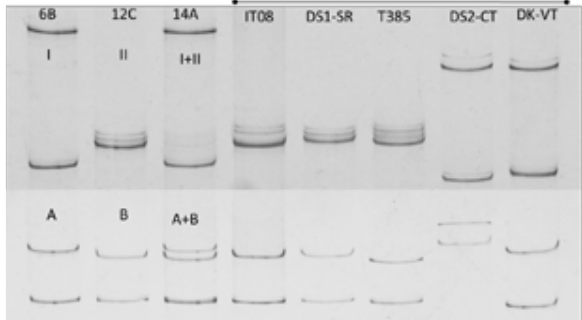
Figure 1. Representative electrophoretic SSCP patterns of RT-PCR products amplified from the CTV Calabrian iso- lates 6B, 12C and 14A, in comparison with those obtained for reference isolates. (Top) Haplotypes I and II recovered for gene p20 . (Bottom) Haplotypes A and B recovered for the gene p25 . Reference isolates IT-08, DS1-SR and T385 have been characterized as mild T30 isolates. Isolates DS2- CT and DK-VT have been associated with VT genotypes and severe symptoms on indicator